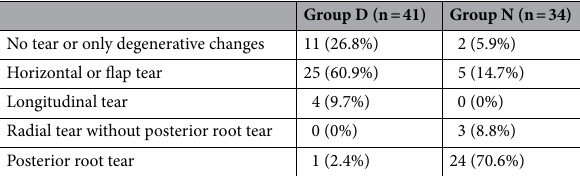
Table 2. Medial meniscus injury formation detected via magnetic resonance